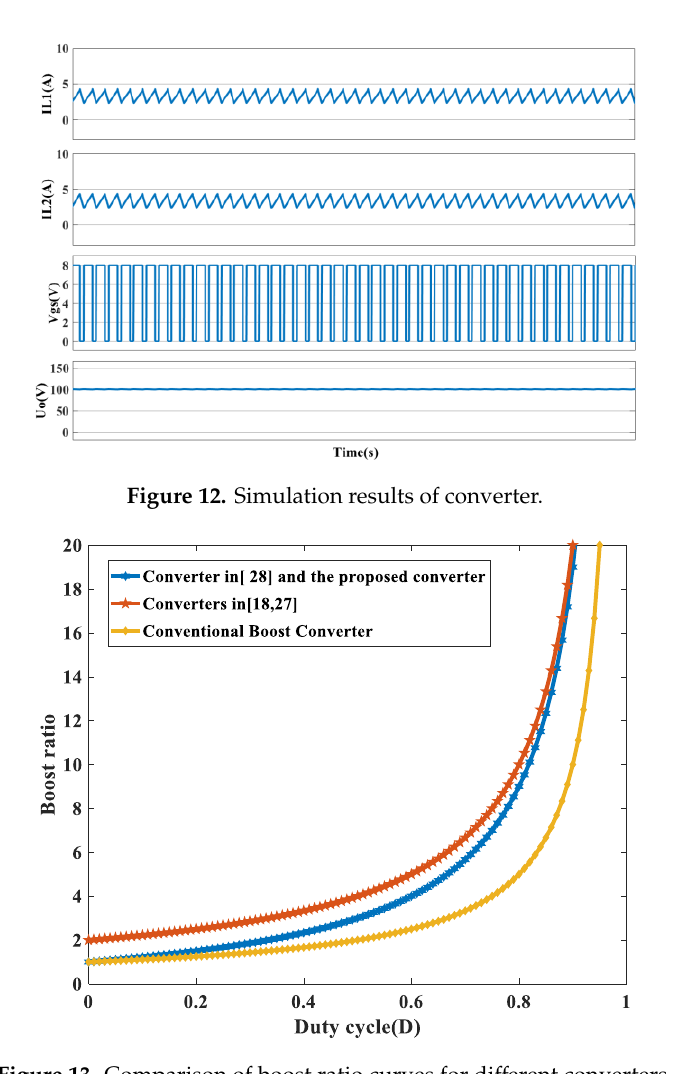
Figure 13. Comparison of boost ratio curves for different converters.